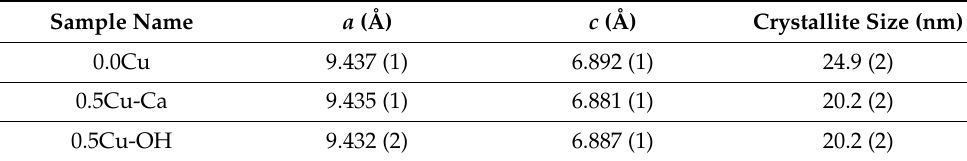
Table 2. Structural characteristics of the synthesized samples.